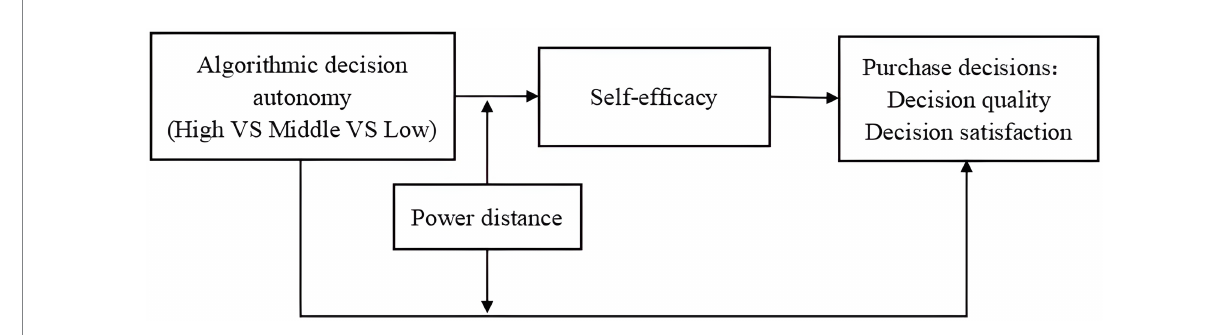
FIGURE 1 Theoretical